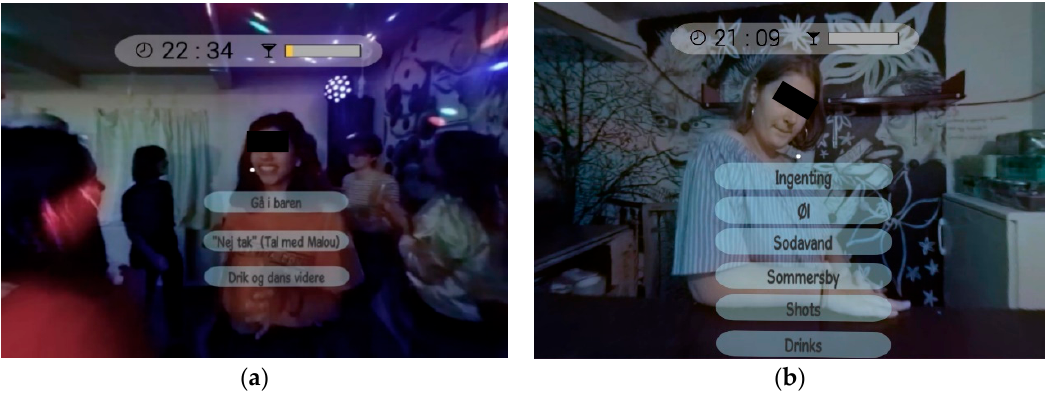
Figure 1. Screenshots illustrating two of the decision points in VR FestLab. ( a ) Scene: Dancefloor. Girl asks: “Would you like something to drink?” Answer possibilities: “Go to the bar”, “No thanks (talk to Malou)”, “Drink and keep on dancing”. ( b ) Scene: Bar. Bartender asks: “Would you like something to drink?” Answer possibilities: “Nothing”, “Beer”, “Soft drink”, “Breezer”, “Shots”.